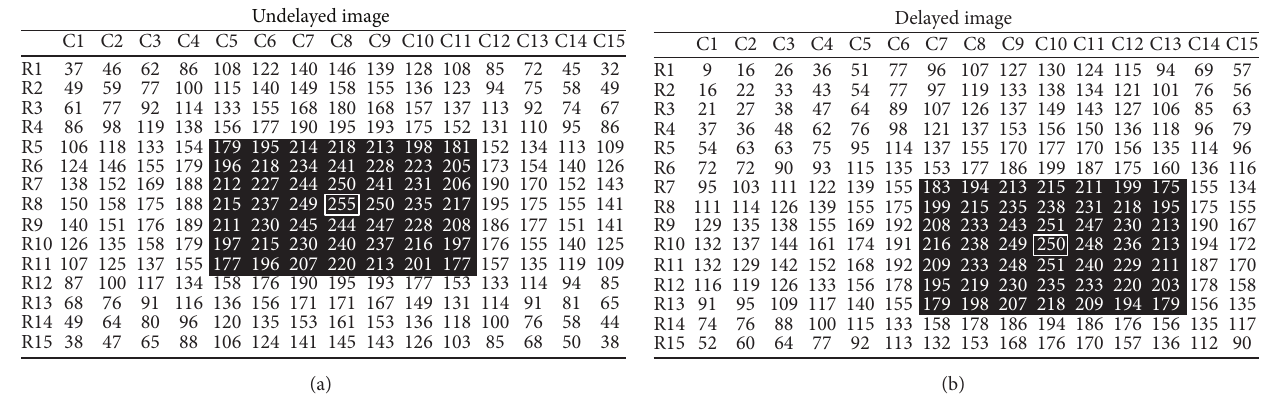
Figure 6: Illustration of spatial correlation technique: (a) a 7 × 7 source window with center at (R8, C8) on the undelayed image and (b) highlighted window on the delayed image whose intensities correlate best with those of source window. Thus the tagged region is displaced two pixels in 𝑋 and 𝑌 direction with the center at (R10, C10); correlation coefficient peak 𝑅 max = 0.9984